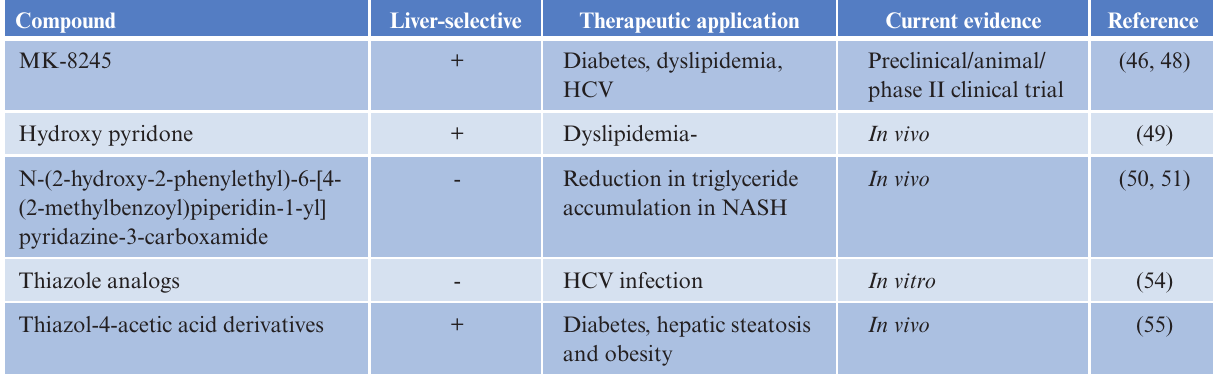
Table 1. Stearoyl-coenzyme A desaturase 1 small molecule inhibitors with potential applications for hepatic diseases.